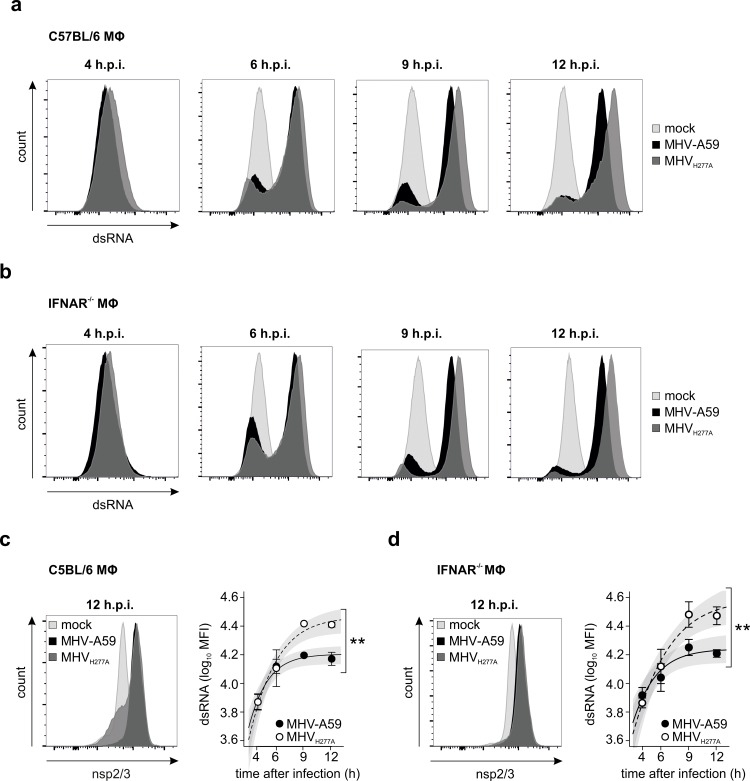
Infection with EndoU-deficient MHV results in increased cytosolic dsRNA.(a-b) Intracellular staining of dsRNA and FACS analysis of MHV-A59 and MHVH277A infected (MOI = 1) C57BL/6 (a) and IFNAR-/-
(b) macrophages at 4, 6, 9 and 12 h.p.i.. One representative histogram out of two (a) and three (b) is shown for each time point. Cells without virus infection (mock) were used as controls. (c-d) The left panels show cells that were co-stained for MHV-nsp2/3 to control for MHV-A59 and MHVH277A infection. The right panels display the median fluorescent intensity (MFI) of dsRNA peaks detected in (a-b). The left panels show data from two (c) and three (d) independent experiments. Cells without virus infection (mock) were used as controls. Mean and SEM are depicted. The 95% confidence band is highlighted in grey. Statistically significant comparisons are displayed (**, p< 0.01).